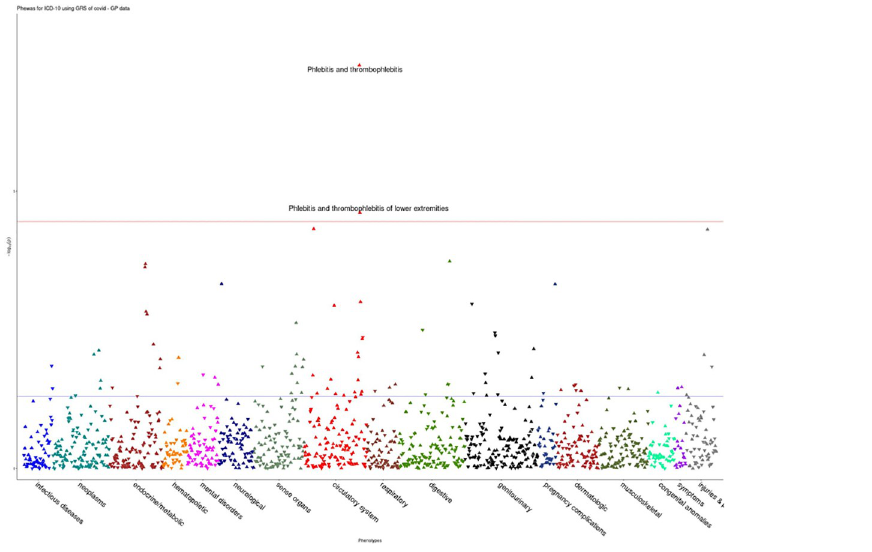
Fig 5. PheWAS associations for COVID-19 susceptibility in GP